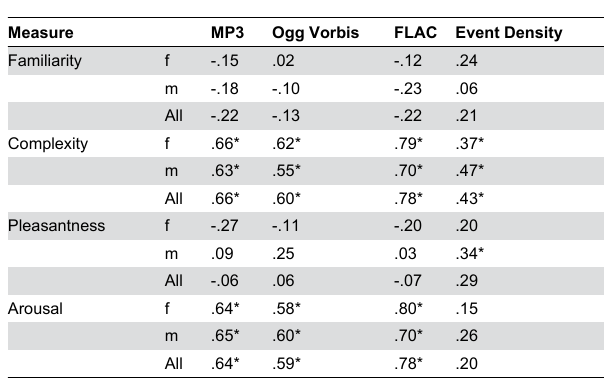
Table 15. Spearman’s rank-order correlations between compression algorithms applied to excerpts of piano solo and piano trio music, their event density and rated familiarity, complexity, pleasantness and arousal (N n ≥ 70, n ≥ males females